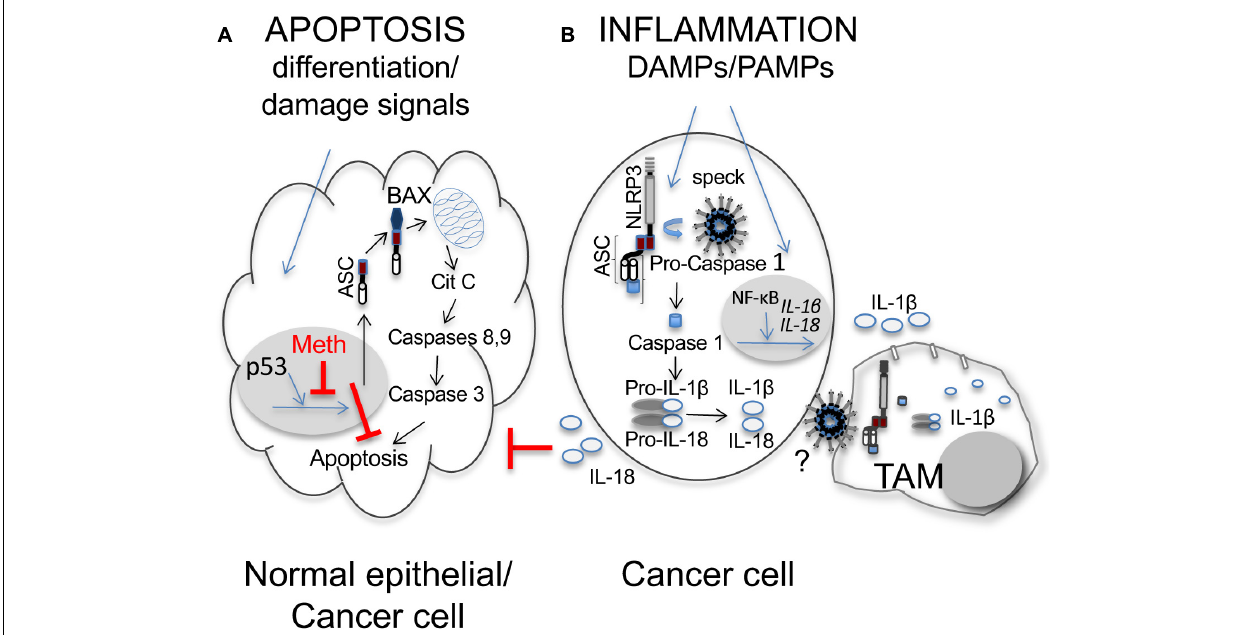
FIGURE 1 | Dual role of ASC/TMS1 in cancer. (A) Pro-apoptotic function. In normal epithelial cells differentiation and stress/damage cell signals induce the onco-suppressor p53 to activate transcription of several genes, among these ASC. Activated ASC binds to Bax and the ASC-Bax complex translocates to mitochondria mediating Citochrome C (Cit C) release. Cit C activates the initiator caspases-8 or -9, which in turn activate caspase-3 and the apoptotic cascade. At difference with normal epithelial cells, in cancer cell methylation (Meth) of the promoter region of ASC induces gene silencing and inhibits apoptosis, thus contributing to cell survival and tumor development (Hanahan and Weinberg, 2011). (B) Pro-inflammatory function in cancer cells. In cancer cells and myeloid cells (such as TAMs), recognition of pathogen- or damage-associated molecular patterns (PAMPs, DAMPs) induces the assembly/polymerization of the inflammasome molecular complex, which in cancer cells is otherwise often constitutively activated as a result of genetic lesions (Kolb et al., 2014; Kantono and Guo, 2017; Karan, 2018; Karki and Kanneganti, 2019). The inflammasome is composed by a multimerized module formed by a sensor Nod Leucine-Rich Repeat-containing receptor, such as NLRP3, bound to the pyrin domain of the adaptor ASC, which in turn is bound, through its CARD domain, to pro-caspase-1. The multimerized complex forms a speck that induces caspase-1 activation. Caspase-1 can then catalyze the proteolytic cleavage and activation of IL-1 β and IL-18. Sensing of PAMPS or DAMPS also induces activation of NF- κ B, which translocates to the nucleus and activates transcription of pro-IL-1 β and pro-IL-18. ASC specks and inflammatory cytokines (IL-1 β and IL-18) are released from cancer cells, through mechanisms not completely elucidated (?), and captured by TAMs contributing to massive IL-1 β release with auto-activation of cancer cells, as well as triggering of other immune or stromal cell components in the tumor microenvironment. IL-18 can contribute to cancer cell proliferation by inhibiting caspase-8 mediated